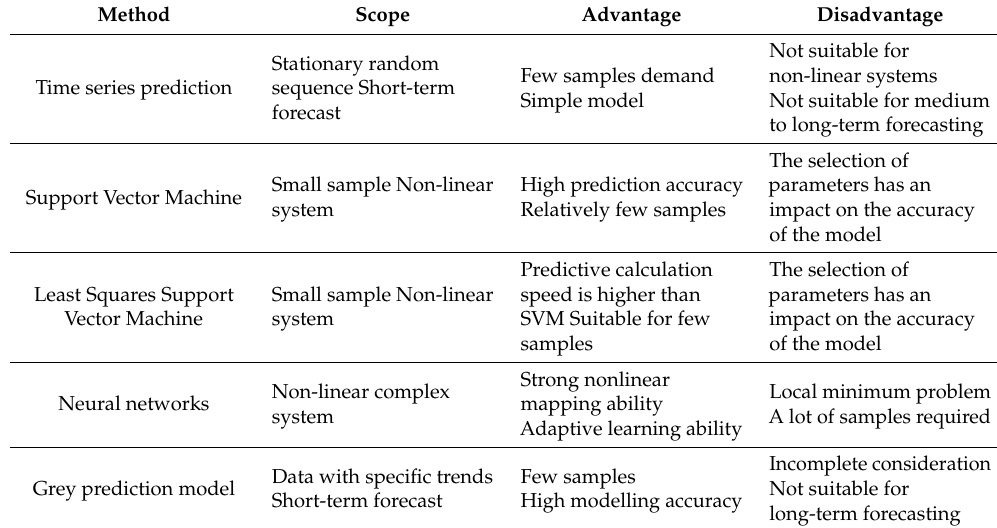
Table 1. Summary of common prediction